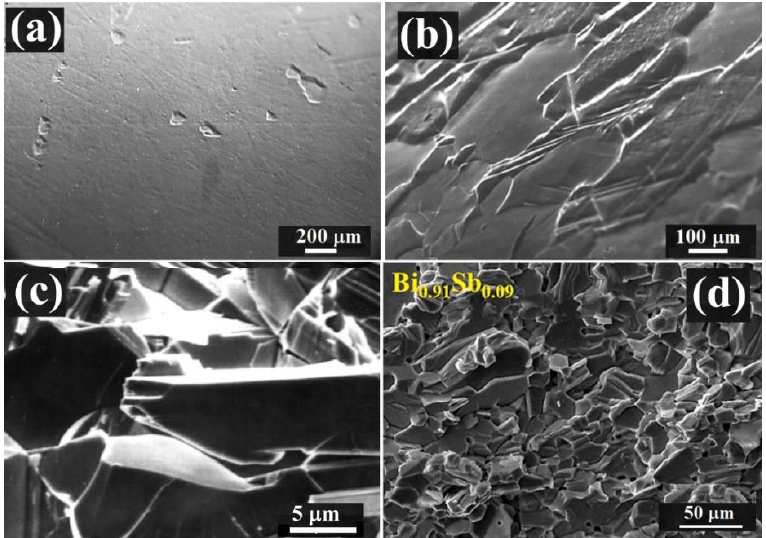
Figure 6. SEM microphotographs of cleavage features ( a – c ) and fracture surface of a typical sample ( d ) in Bi 0.91 Sb 0.09 extruded samples. ( a ) General view of the cleaved surface perpendicular to the extrusion axis with triangular etching pits; ( b – d ) annealing at 453 K for 8 h with K e 1.2 ( a ), 3 ( b ), and 5 ( c ) at 1000 MPa and 300 K.